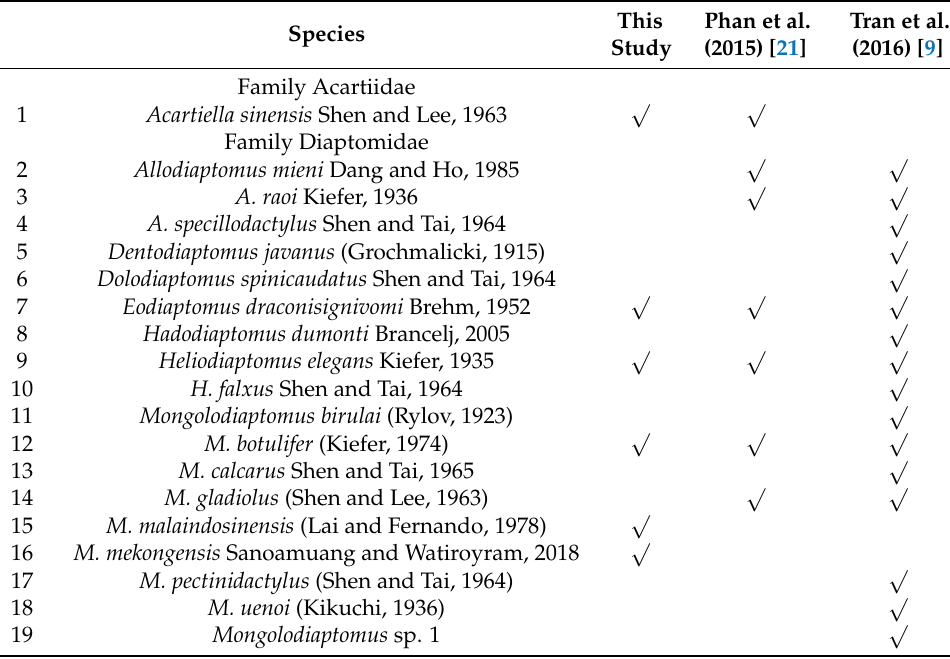
Table 5. Updated list of calanoid copepods recorded in Vietnam.